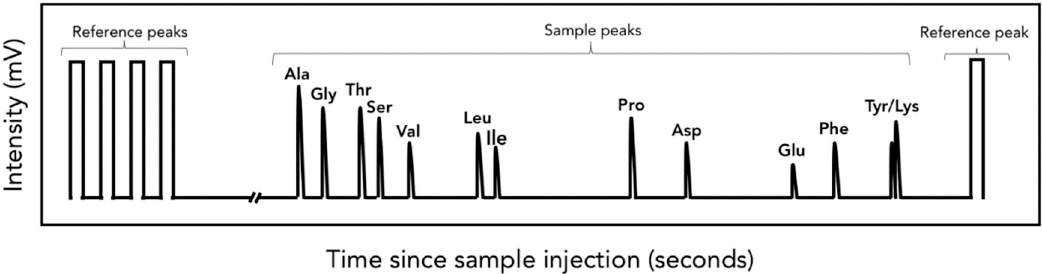
Figure 2. A typical amino acid (AA) chromatogram of a sample prepared with the Silfer et al. [53] derivatization method. Here the X axis has been broken for clarity; typical injections take ~1 h. Included are peaks of reference gas (square) and individual AA from the sample (rounded). AA with simpler molecular structures tend to elute earlier (e.g., Gly and Ser) whereas more complex AA require more time to pass through the GC column (e.g., Phe, Lys). Although a single line is shown for clarity, chromatograms have multiple lines representing different atomic masses that are then integrated to calculate isotopic ratios. During carbon analysis, lines represent atomic masses 44, 45, 46; during nitrogen analysis, masses 28, 29, 30; and during hydrogen analysis, masses 1 and 2.